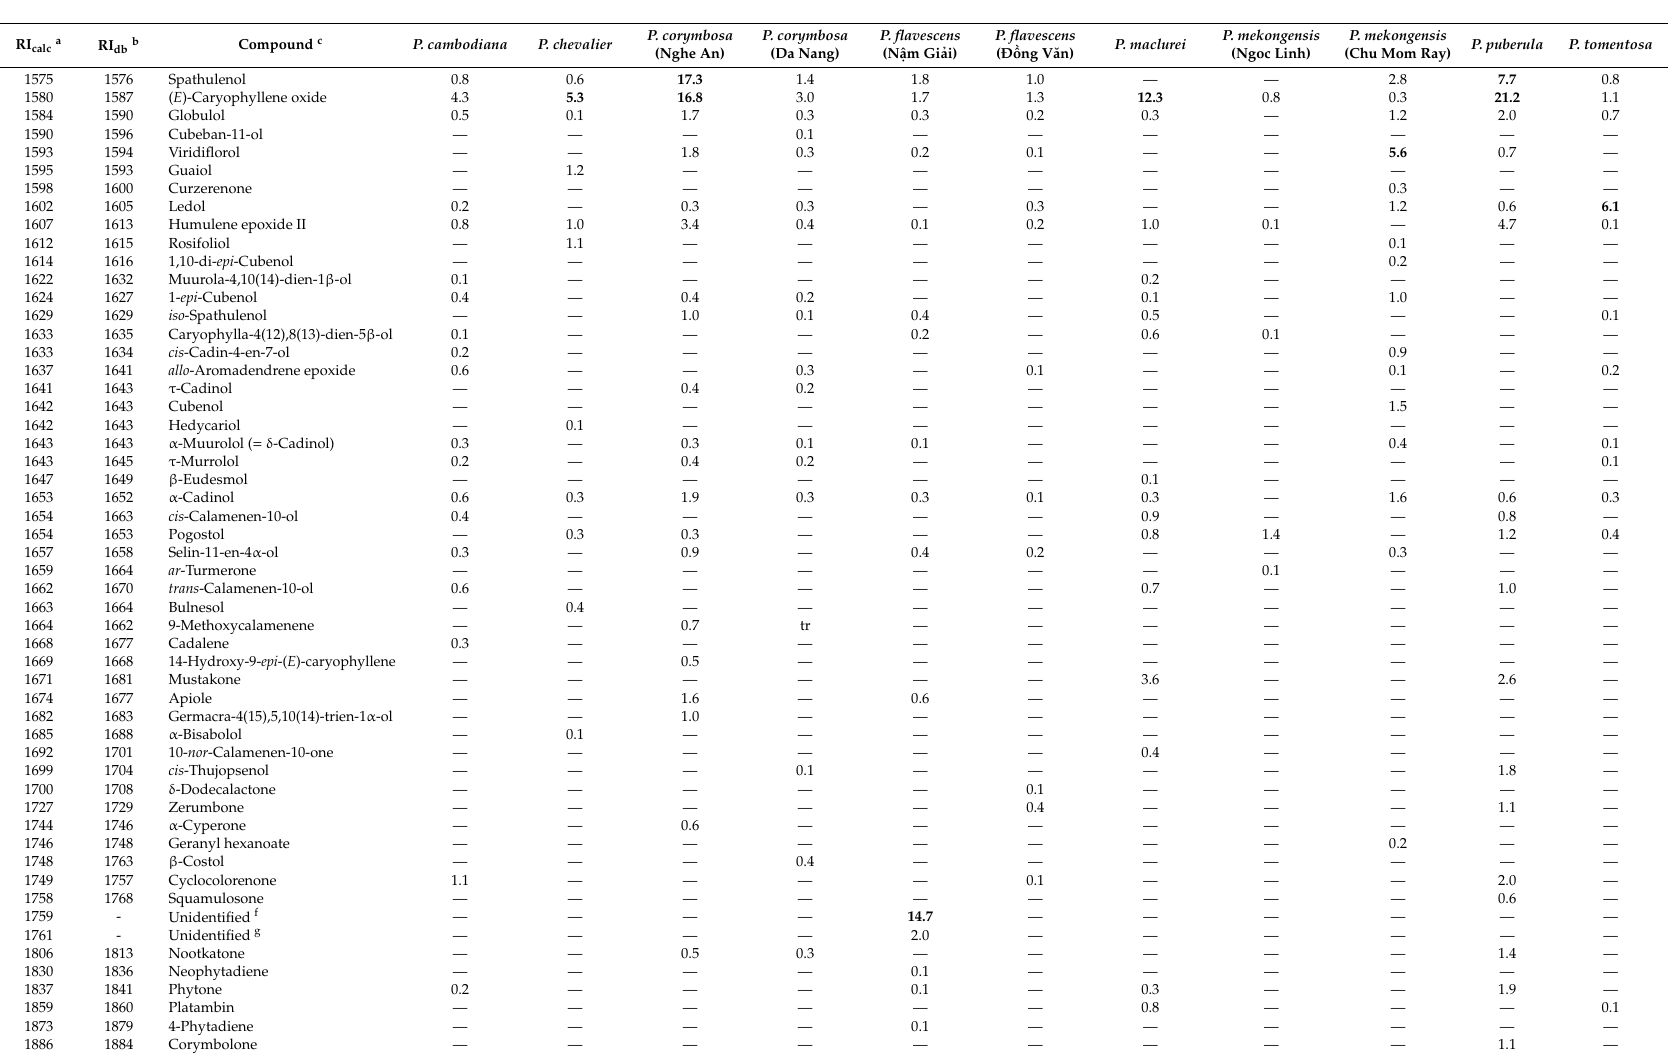
— — — — — — — 1664 — — tr — — — — — — — 1668 — — — — — — — — — — 1669 — — — — — — — — 1671 — — — — — — — — 1682 — — 1.0 — — — — — — — — 1685 — — — — — — — — — 1692 — — — — — — 0.4 — — — — 1699 — — — 0.1 — — — — — 1.8 — 1700 — — — — — 0.1 — — — — — 1727 — — — — — — — — 1.1 — 1744 — — 0.6 — — — — — — — — 1746 — — — — — — — — 0.2 — — 1748 — — — — — — — — — 1749 — — — 0.1 — —